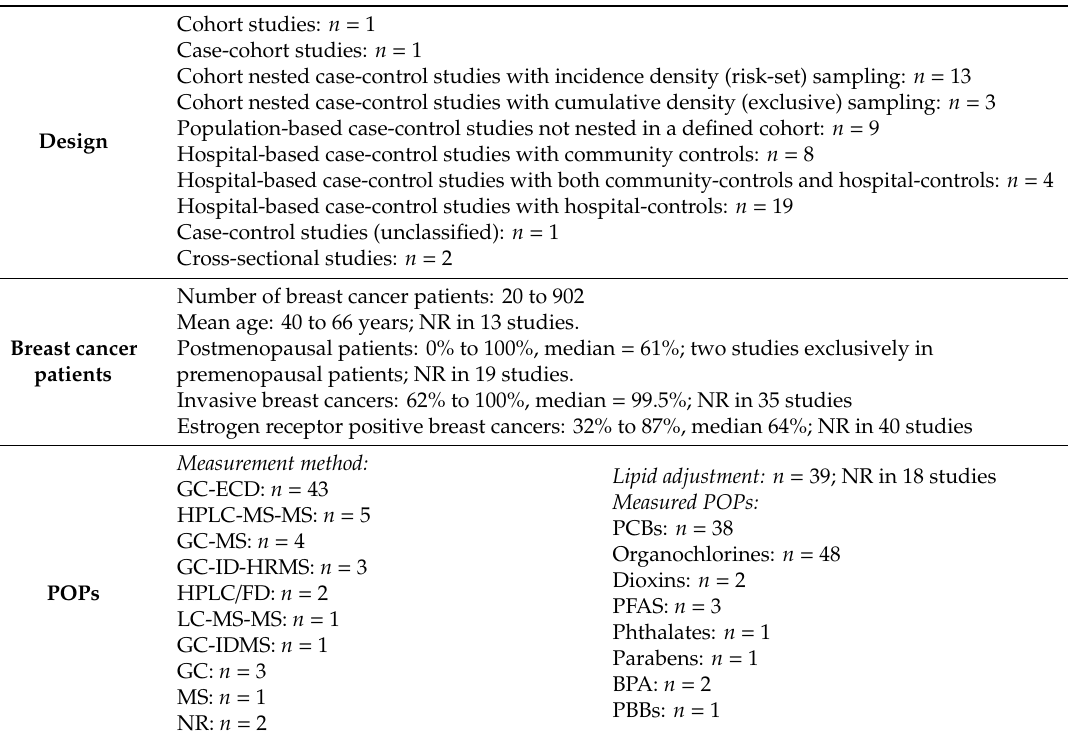
Table 1. Summary characteristics of studies of peripheral blood POPs and breast cancer risk ( n = 61).